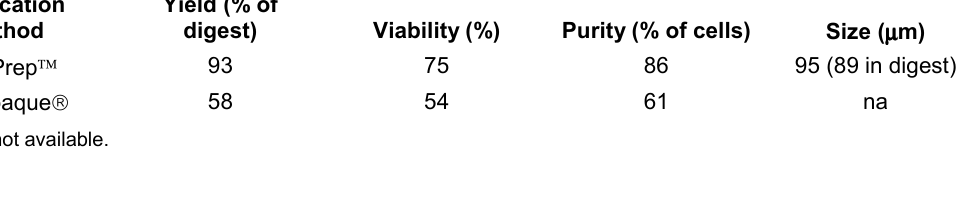
Comparison of Islet Purification